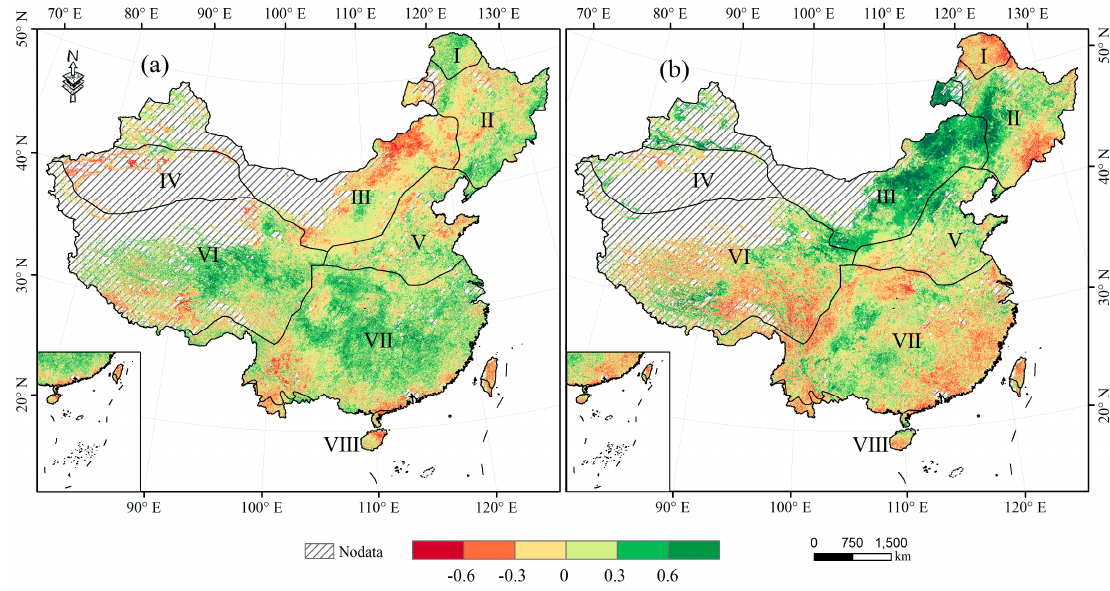
Figure 8. Spatial correlations between annual mean BESS GPP and the corresponding temperature ( a ) and precipitation ( b ) across different climate zones in China from 2001 to 2015. Table 2. Area statistic of the correlations between annual mean BESS GPP and the corresponding temperature and precipitation in China from 2001 to 2015.